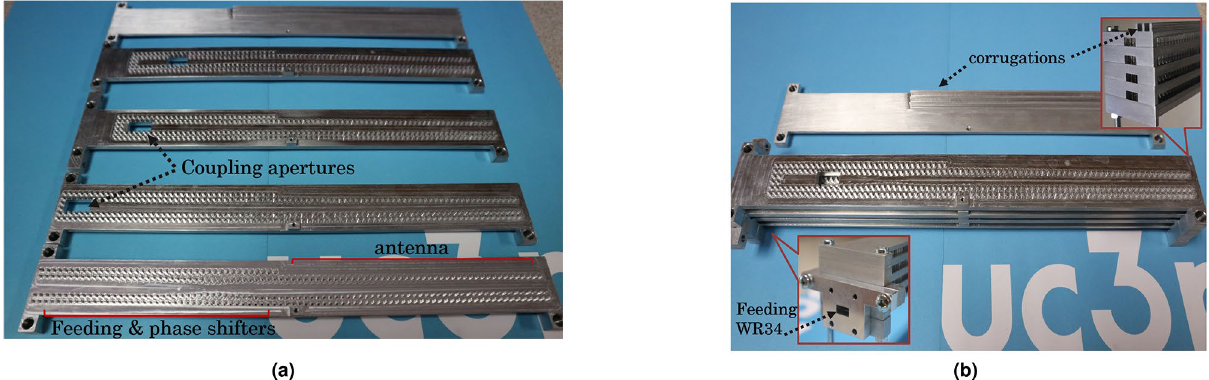
Figure 11. The fabricated prototype. In ( a ) the different elements of the array are shown separately. In ( b ) the antennas are stacked to form the array. In the insets, the front and back of the array is shown.